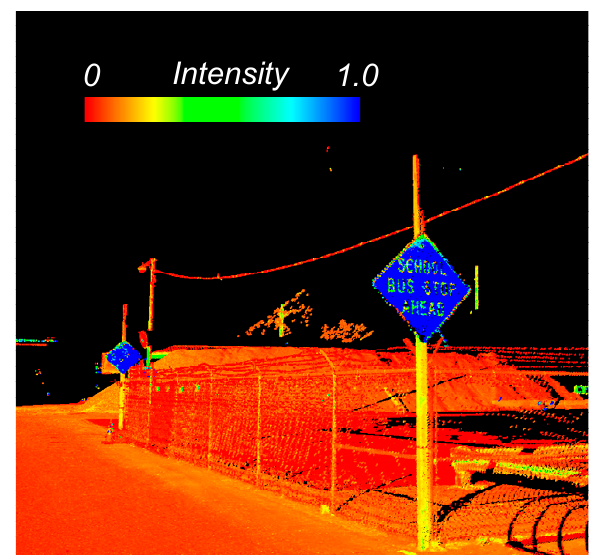
Figure 7. MLS point cloud at a traffic sign colored by intensity values.